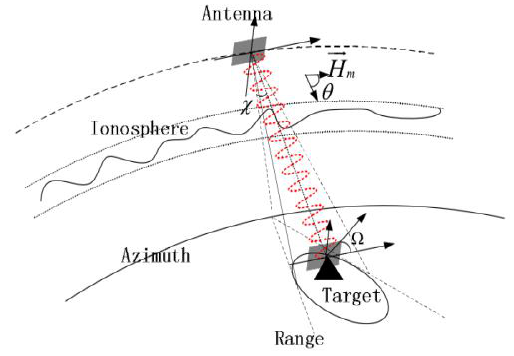
Figure 7. Schematic of electromagnetic wave through the ionosphere.